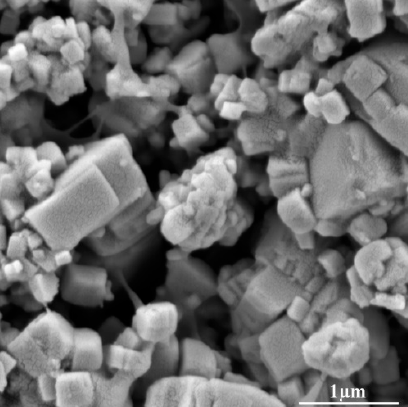
Figure 10. SEM image of the fracture surface of the KNN dried green body.